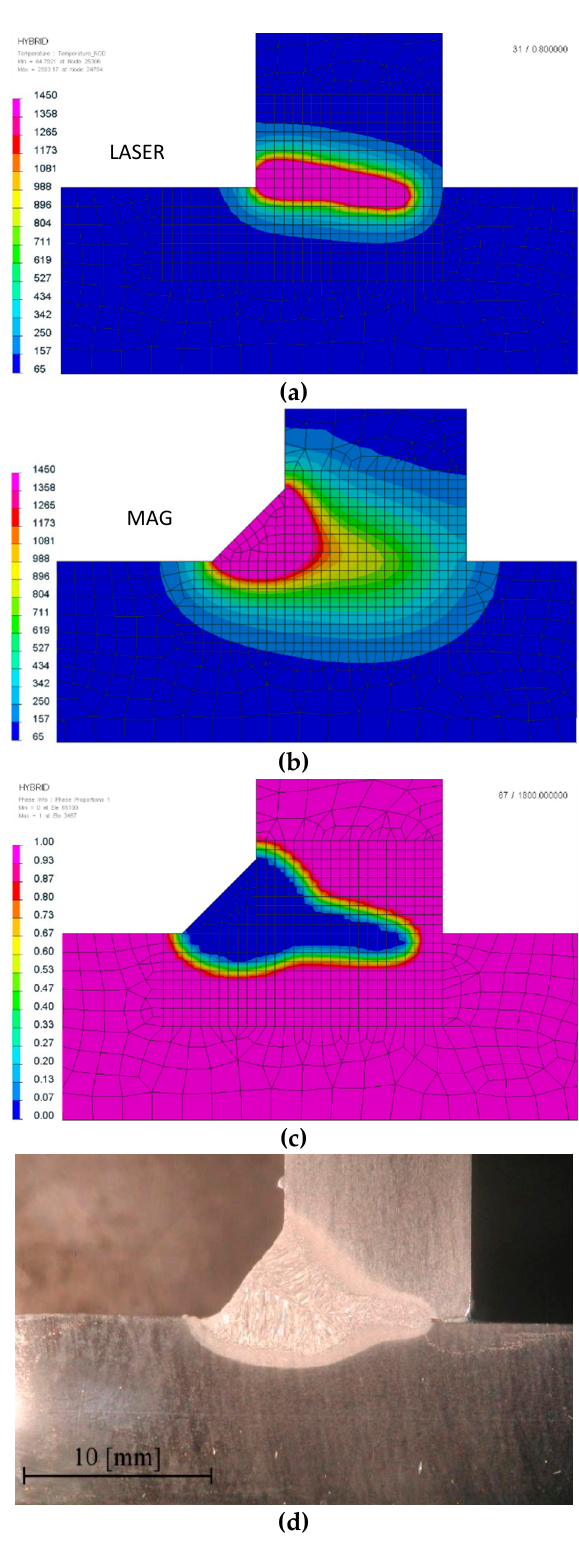
Figure 5. Hybrid welding temperature field distribution separately for ( a ) the laser and ( b ) the GMAW arc, and comparison of a ( c ) ferrite/pearlite as an initial phase distribution with (d) a macro-section of a welded joint (the blue color is the estimated melted zone/weld area; cross-sections were made in the half-length of the joint).